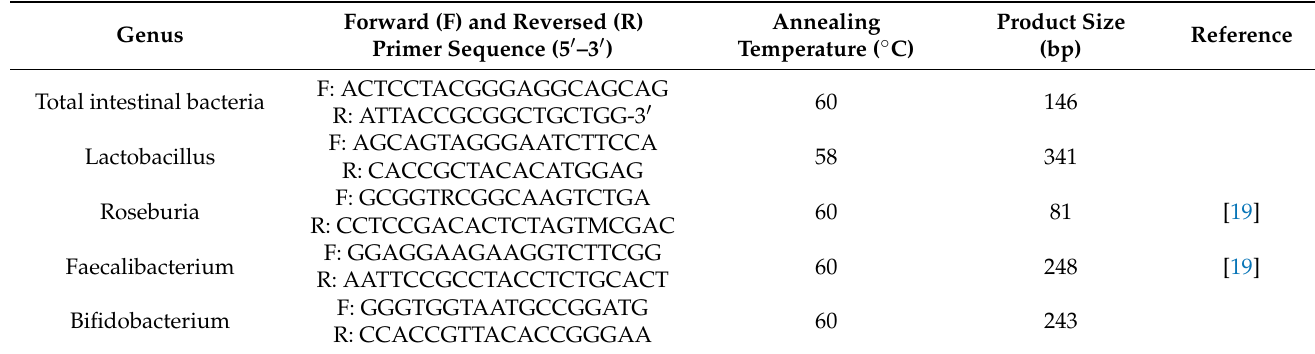
Table 1. Genus-specific primers used for real-time qPCR.